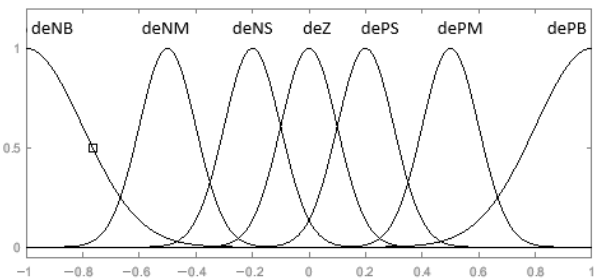
Figure 4. Membership functions for error.